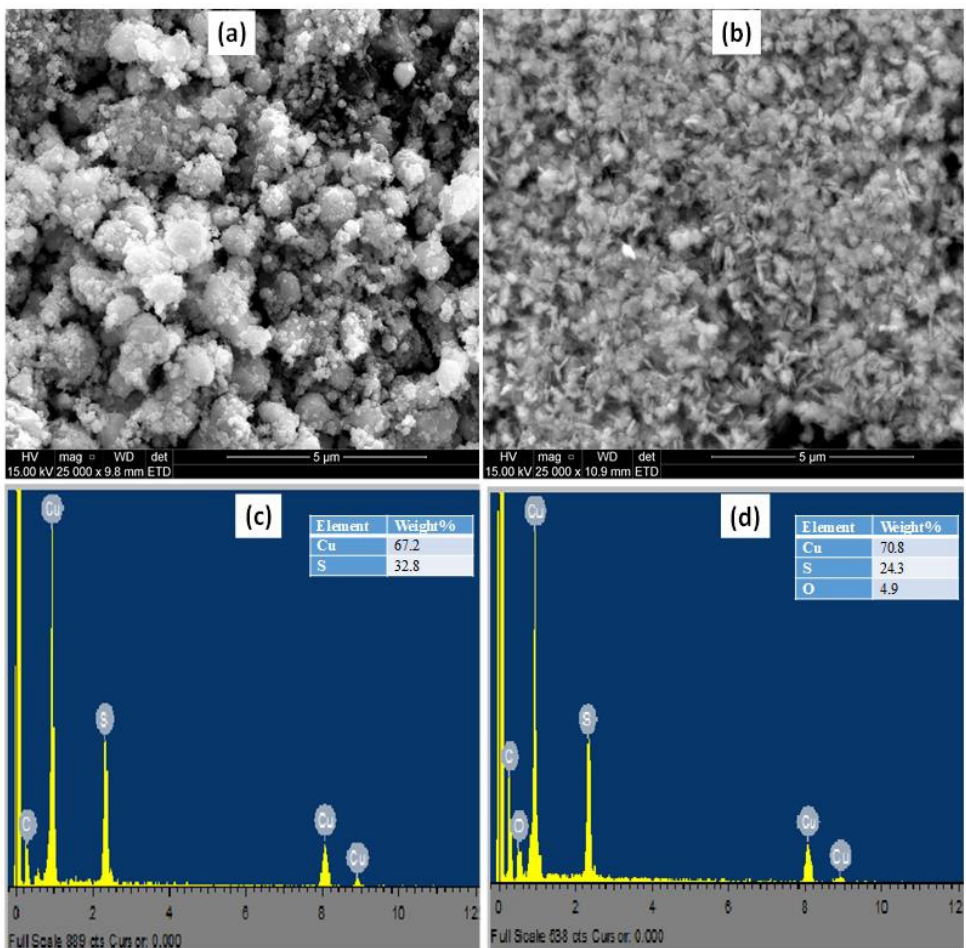
Figure 2. ( a , b ) SEM and ( c , d ) EDX of covellite (CuS) and digenite (Cu 9 S 5 ) nanoparticles,